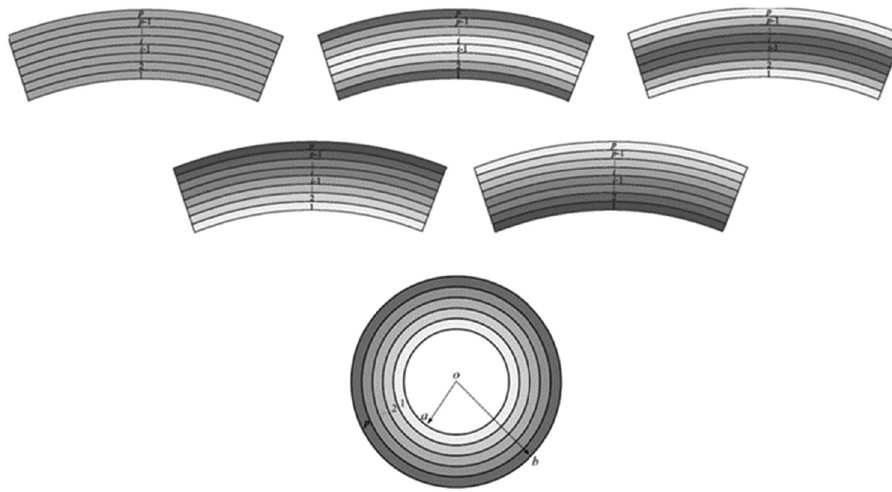
Figure 1: Geometric shell con fi guration [ 18 ] .